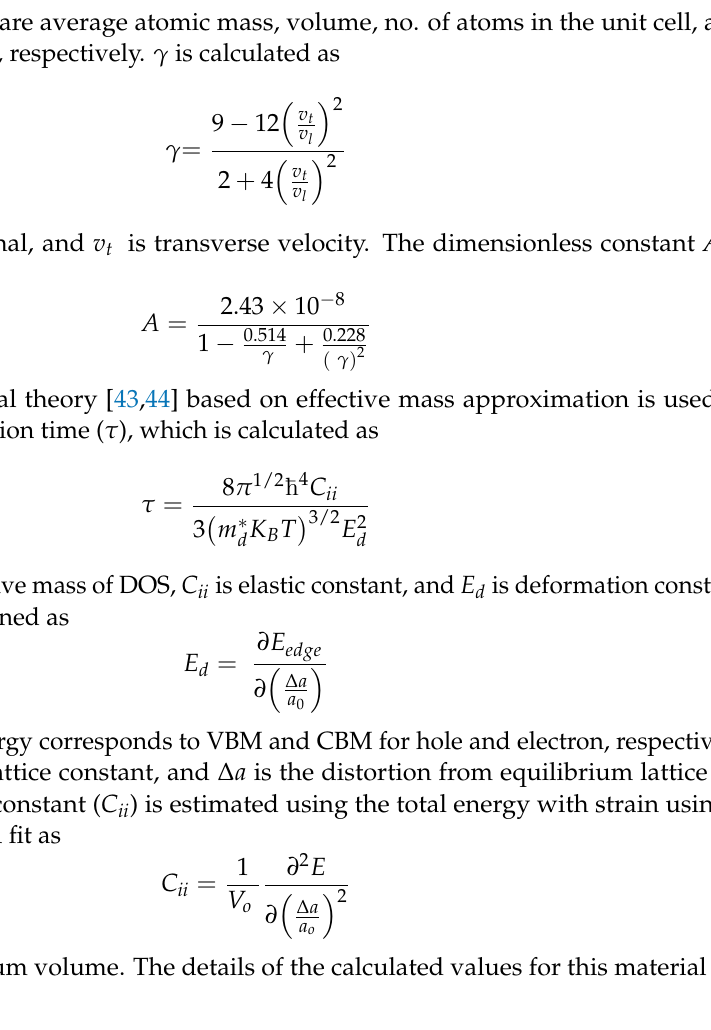
Table 1. DOS effective masses ( m ∗ ), deformation constant ( E d ), elastic constant ( C ii ), and relaxation d time ( τ ) of PdZrSn and PdHfSn at 300